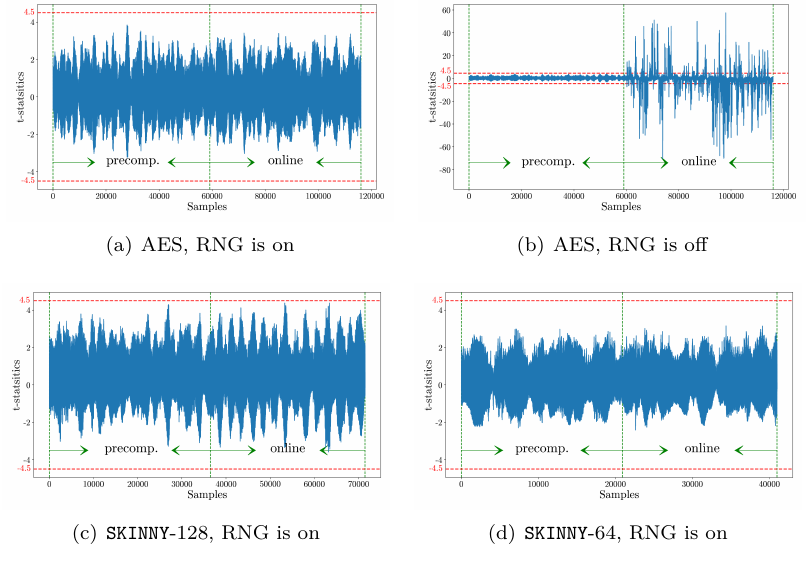
Figure 5: T-test